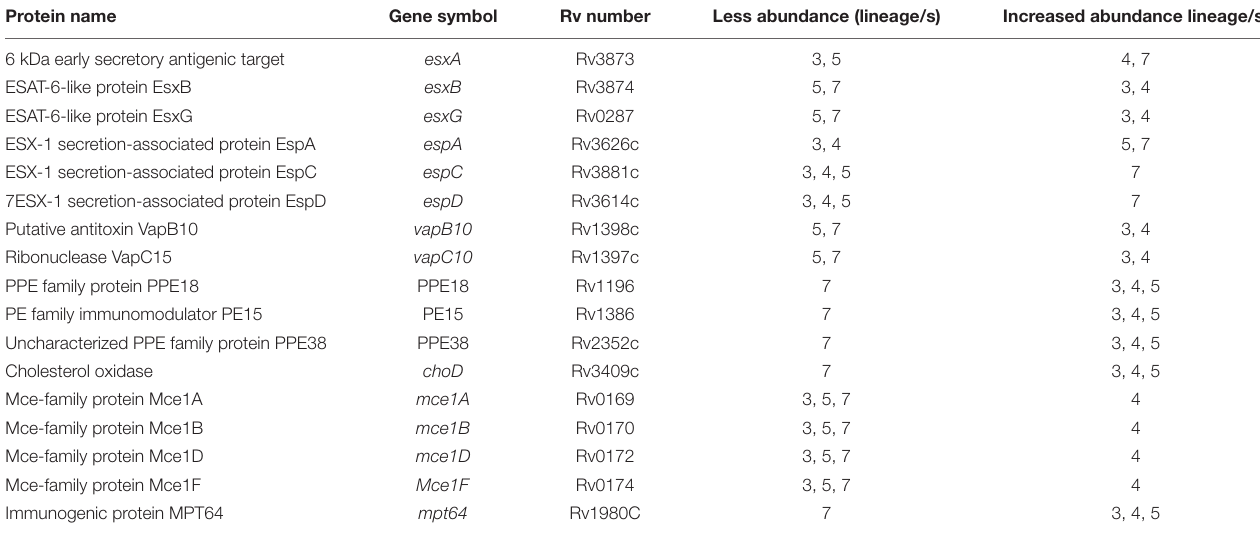
TABLE 2 | Differentially abundant proteins in the ESX-1 secretion system and other virulence related proteins in MTBC